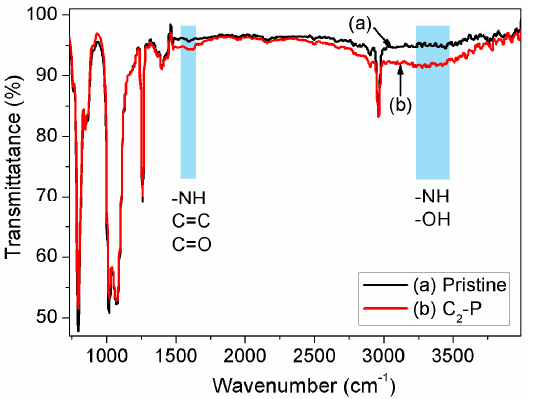
Figure 5. FTIR (ATR) spectra of ( a ) pristine PDMS and ( b ) PDA-coated PDMS (C 2 -P) .